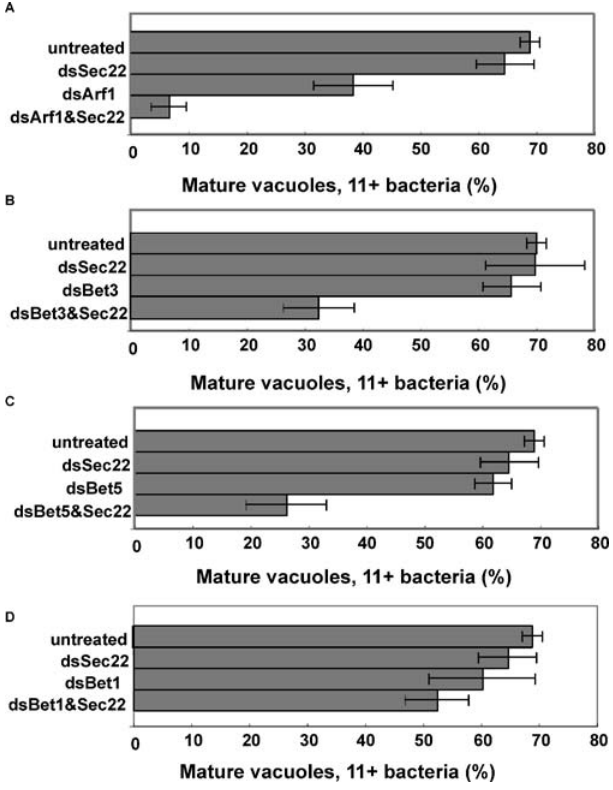
Figure 1. RNAi Targeting Multiple Secretory Components Decreases L. pneumophila Replication dsRNA-treated Kc167 cells were incubated for 1 h with L. pneumophila at MOI ¼ 1, washed, and incubated for 30 h prior to microscopic examination of replication vacuoles. The noted dsRNAs were added to Drosophila cells, and allowed to incubate with the cells prior to introduction of L. pneumophila, as described (see Materials and Methods). Untreated: no dsRNA added. The mean 6 standard error is plotted. DOI: